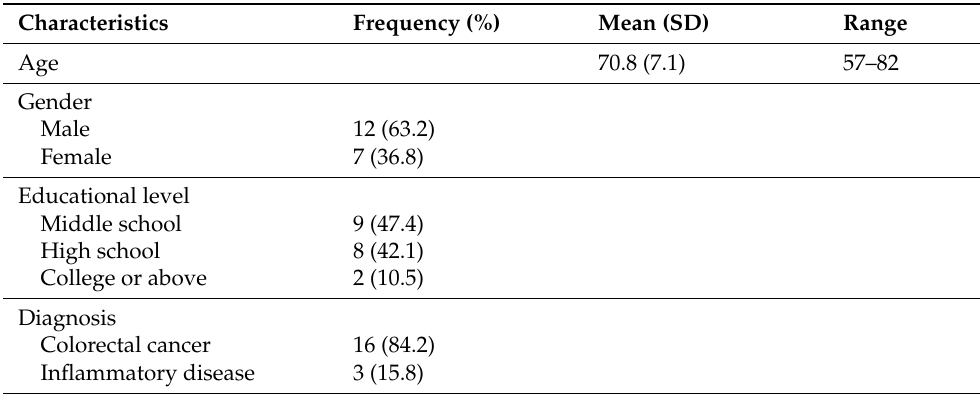
Table 2. Characteristics of informants ( N =